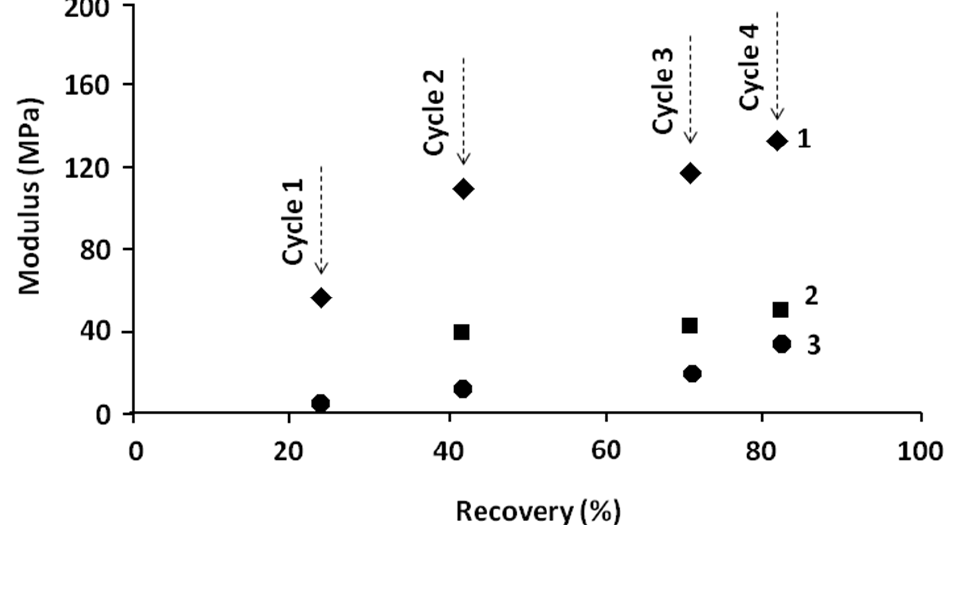
different successive